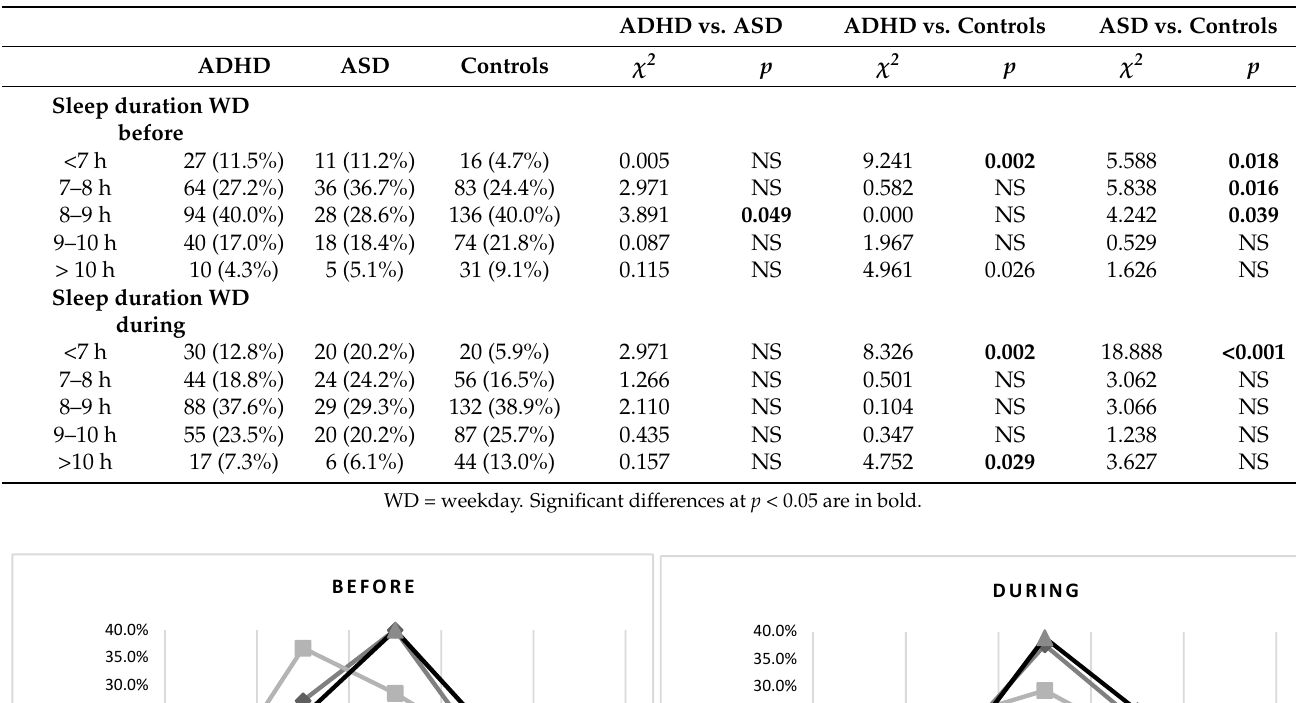
Table 4. Comparison between sleep duration in weekdays before and during lockdown in the three groups. ADHD vs. ASD ADHD vs. Controls ASD vs. Controls